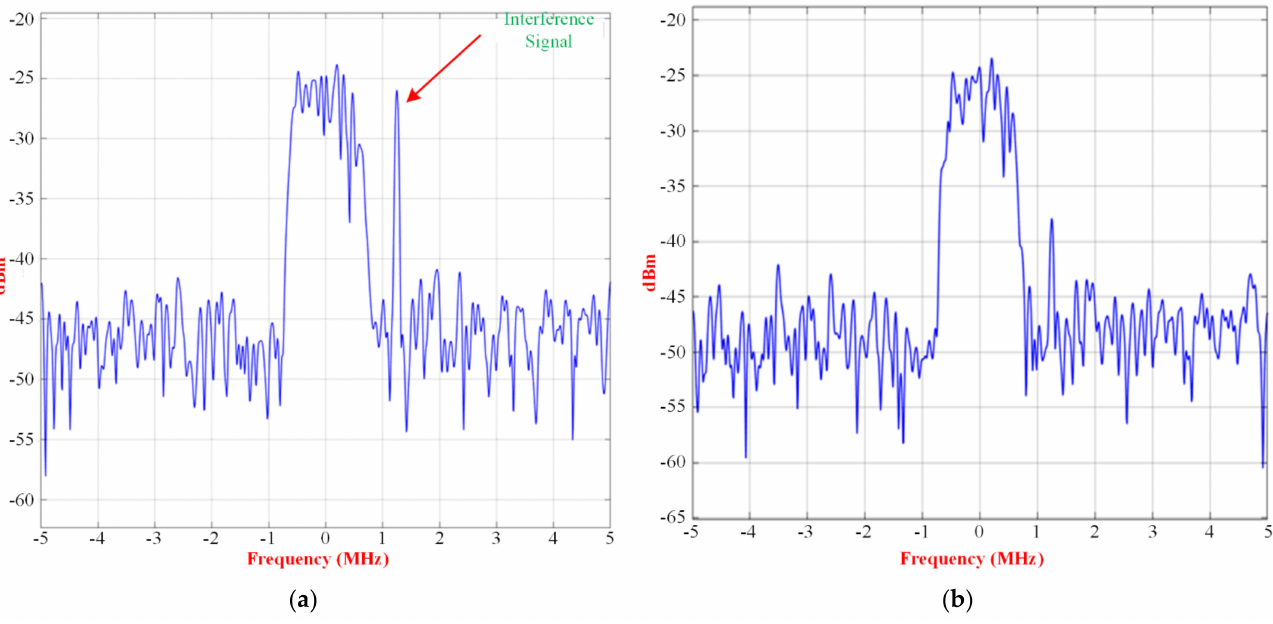
Figure 24. Signal (channel 1) and interference (channel 2) input spectrum of the RF transmitter. The signal and interference input spectrum of the RF receiver, without beamforming and with beamforming, case 1, case 2, and case 3, are shown in Figures 25–27, respectively.